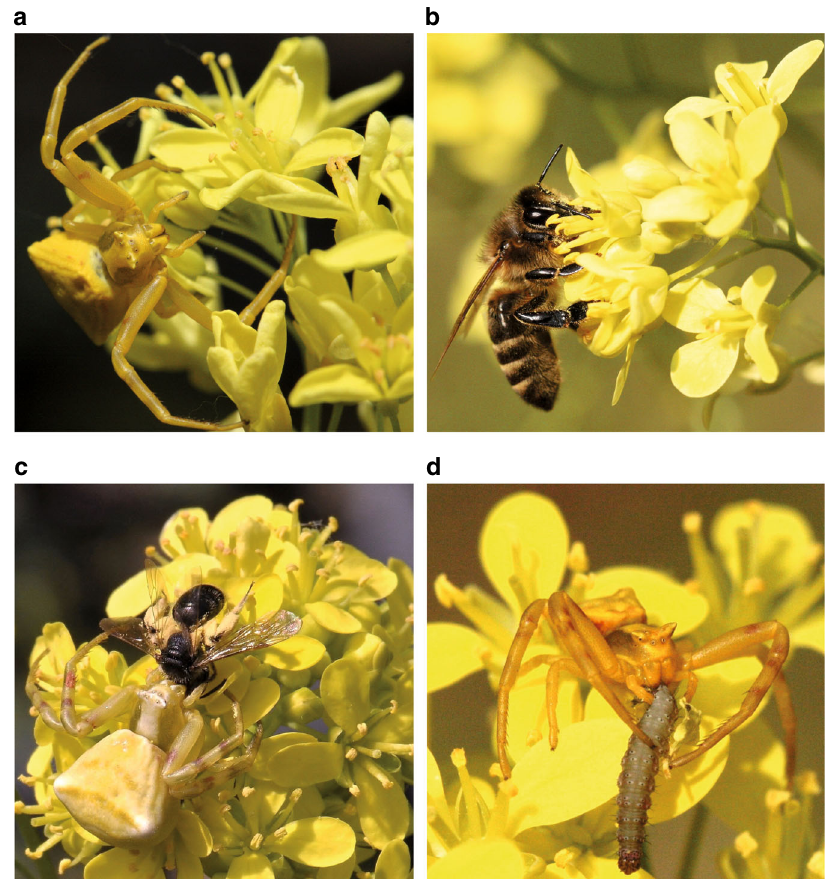
Fig. 1 The buckler mustard ( Biscutella laevigata ) and various interacting organisms. a A crab spider ( Thomisus onustus ) on B. laevigata fl owers. b A honey bee ( Apis mellifera ) visiting B. laevigata fl owers. c A crab spider feeding on a wild bee ( Halictus sp.) d A crab spider feeding on a fl orivore (Plutella xylostella) . All photos by A.C.